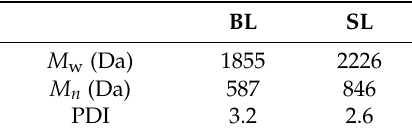
Table 1. Average molecular weight of lignin extracted from birch (BL) and spruce biomass (SL). Reprinted with permission from [17]. Copyright (2016) American Chemical